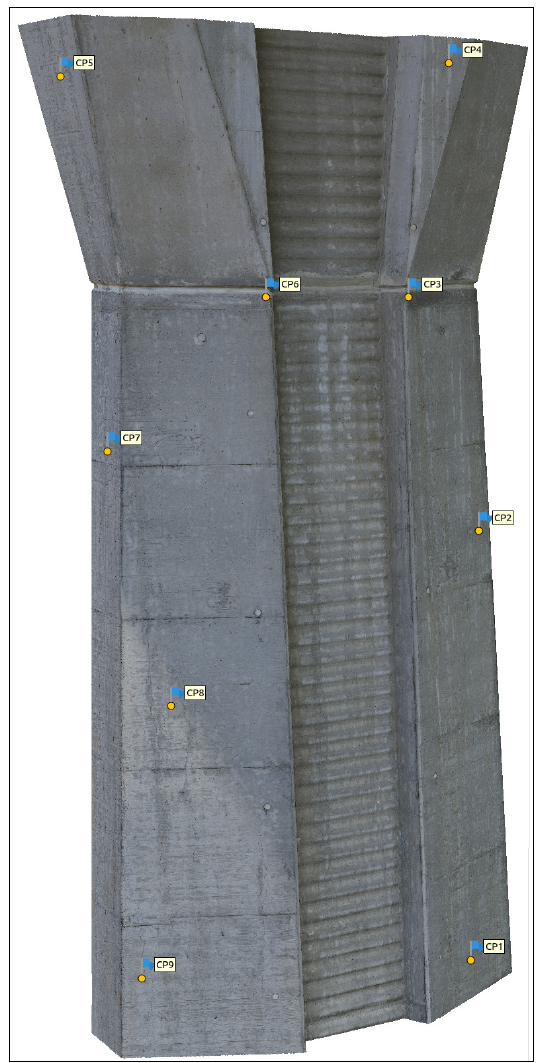
Figure 6. 3D model of a segment of bridge pier with assigned control